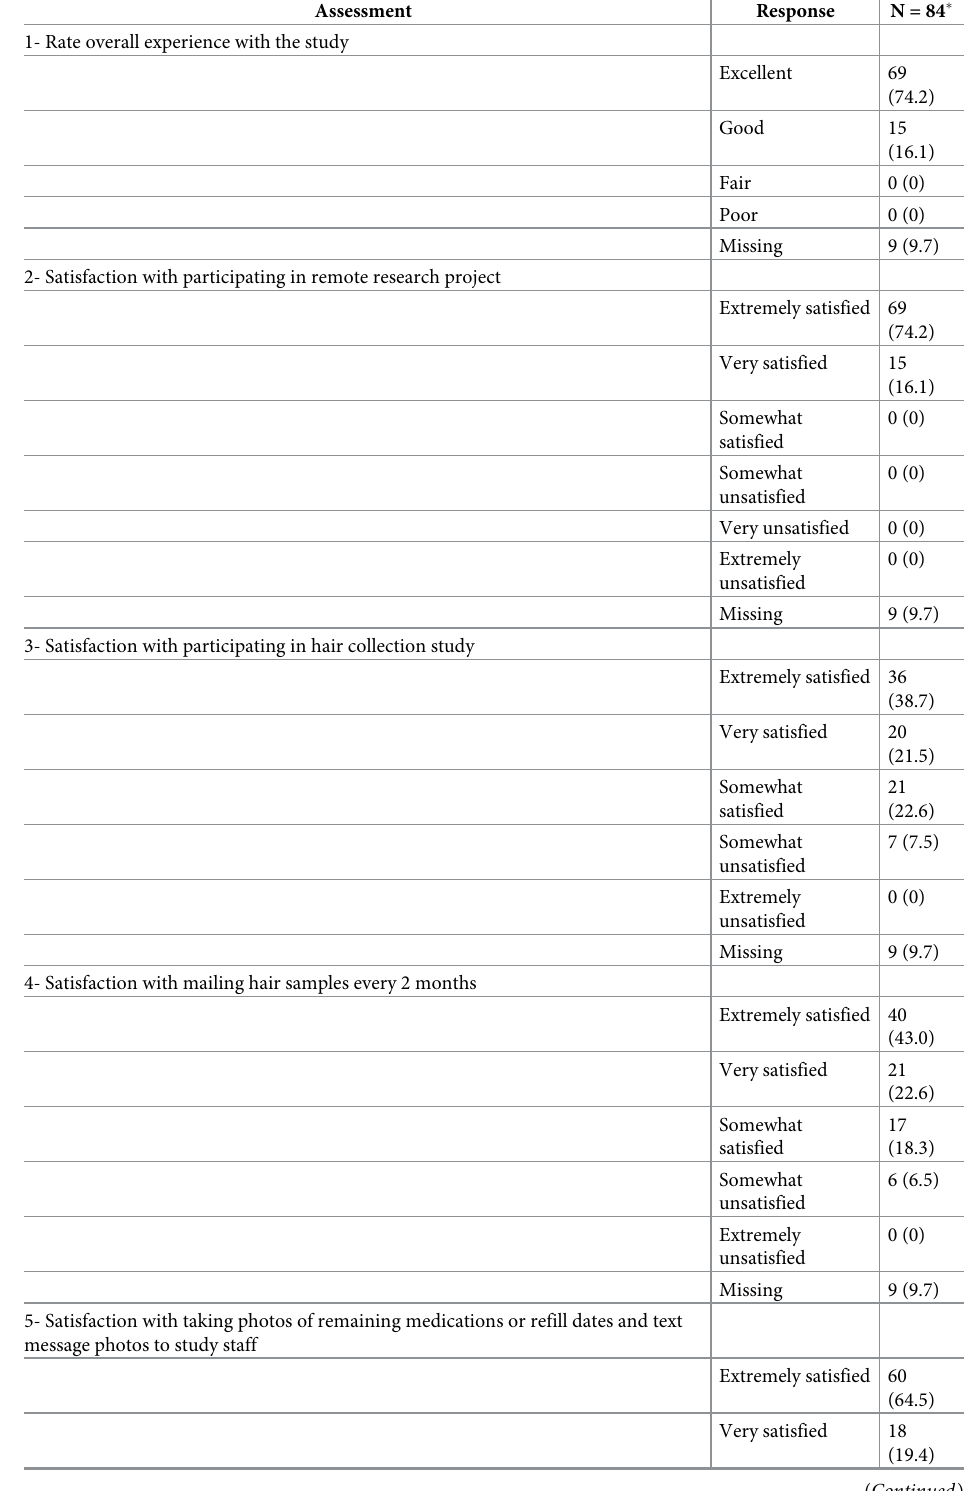
Table 4. Responses to exit